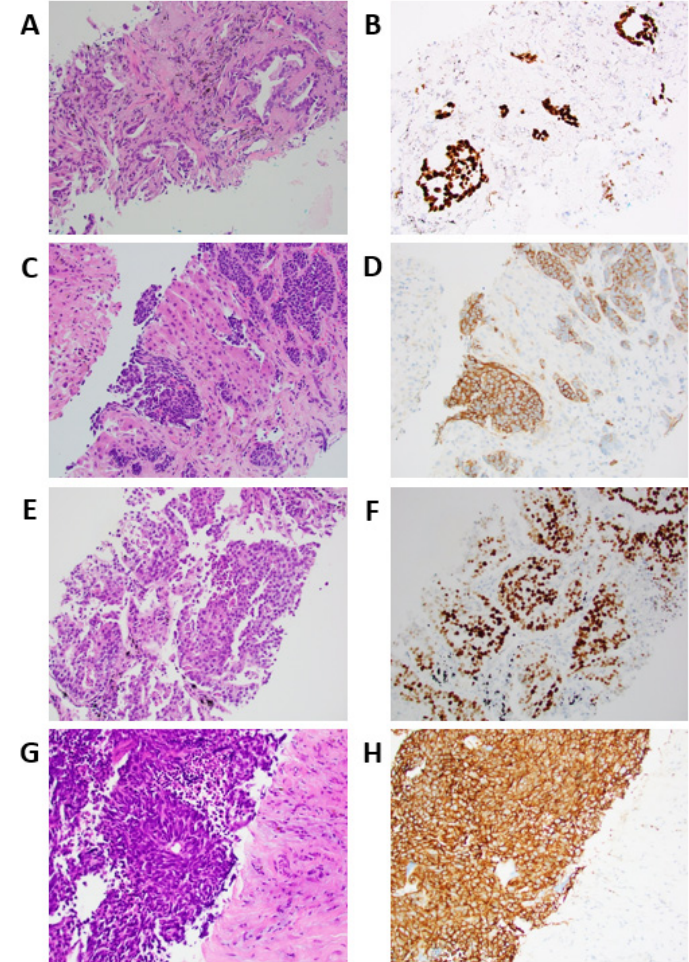
Figure 1. Tissue staining of two patients with transformation. ( A ) H&E stained section of acinar-type adenocarcinoma grade 2, initial diagnosis, H&E × 200 (Patient 9). ( B ) Acinar-type adenocarcinoma, TTF1 stain × 200. ( C ) H&E section, small cell transformation to liver × 200. ( D ) Small cell transfor- mation to liver, synaptophysin stain, × 200. ( E ) H&E stained section of solid-type adenocarcinoma grade 3, initial diagnosis, H&E ×200 (Patient 7). ( F ) Solid ‐ type adenocarcinoma, TTF1 stain ×200. ( G ) H&E section, small cell transformation to liver ×200. ( H ) Small cell transformation to liver, synapto ‐ physin stain ×200.